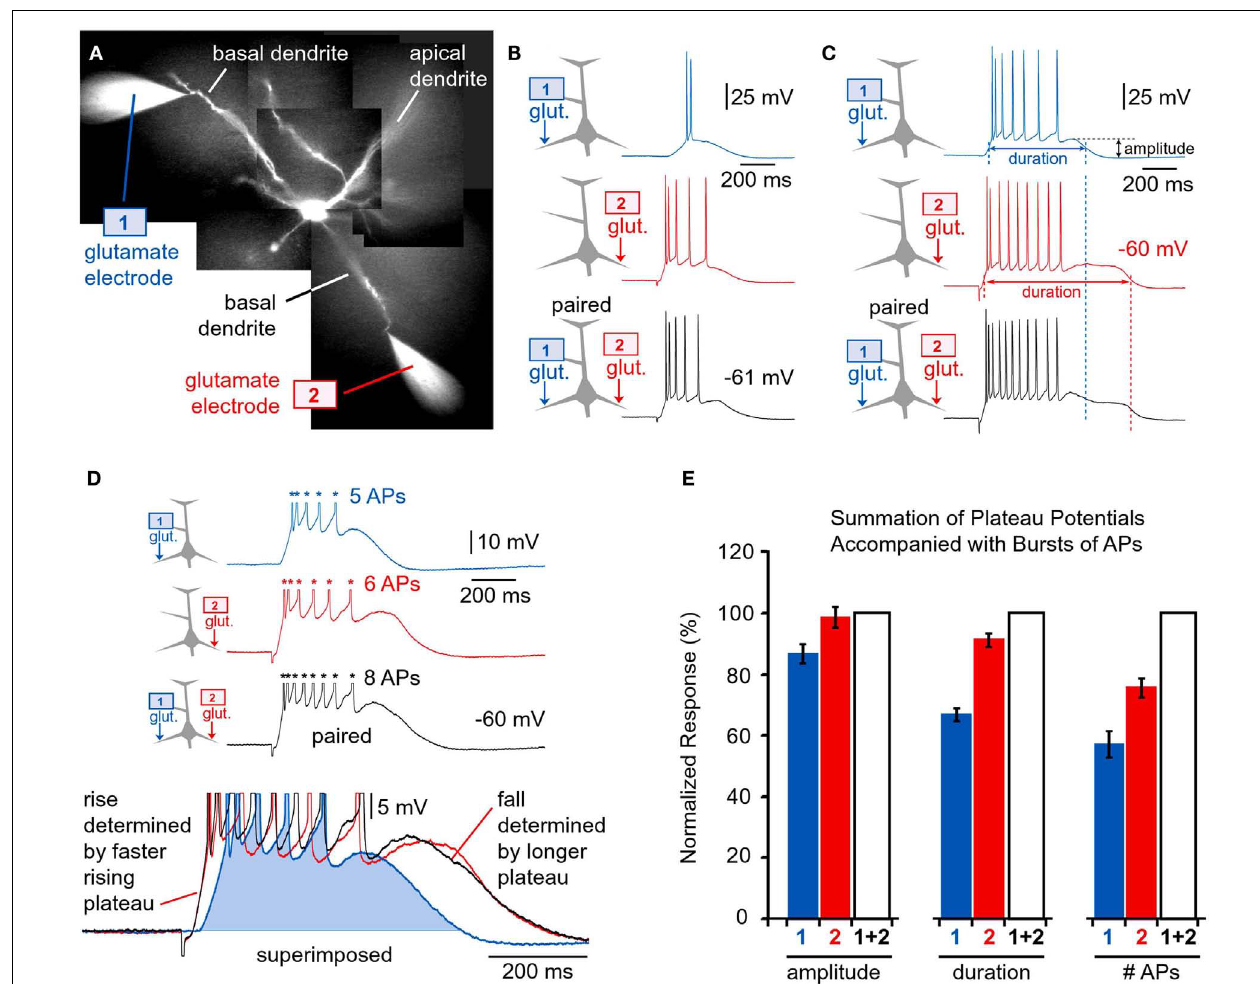
paired). (E) Amplitude of the glutamate-evoked depolarization [slow component amplitude marked in (C) ] is divided by the plateau amplitude obtained during co-activation ( 1 + 2 ), and averaged across nine neurons; 21 triplets of sweeps. Duration of the plateau depolarization was measured at half amplitude [as indicated in (C) ], normalized against 1 + 2 and averaged across 21 triplets of sweeps obtained in nine neurons.The number of action potentials (#AP) was normalized against trace “ 1 + 2 ” and averaged across seven neurons. Plateau potentials of smaller amplitude and shorter duration (blue traces) are completely eclipsed by larger and longer plateaus (red traces), when paired (black